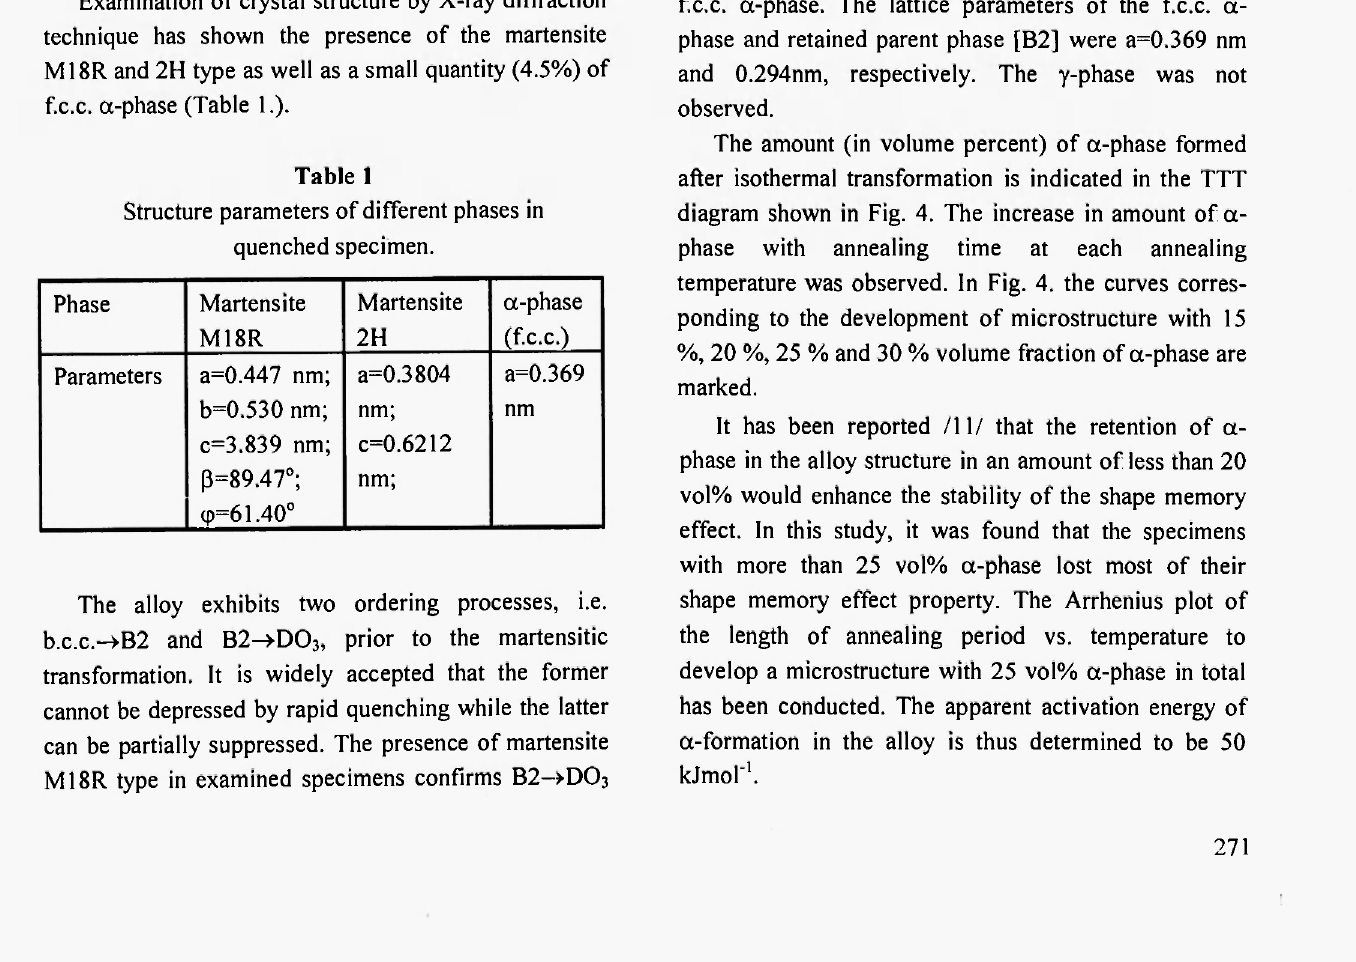
Fig. 1: Optical microstructure of quenched specimen (50x).